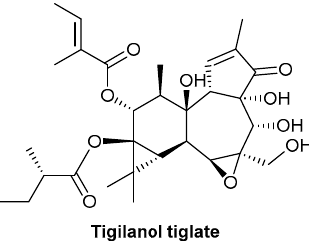
Figure 13. Chemical structure of tigilanol tiglate, the main component of Fontainea picrosperma .